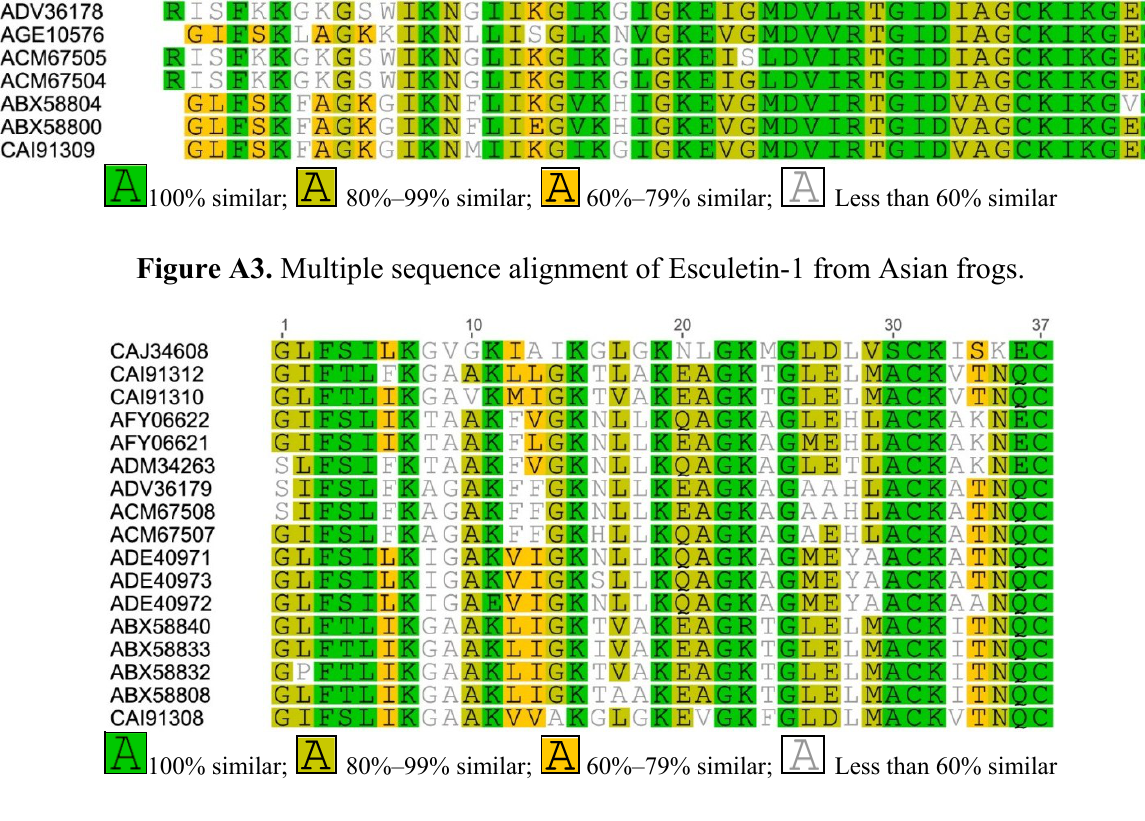
Figure A4. Multiple sequence alignment of Esculetin-2 from Asian